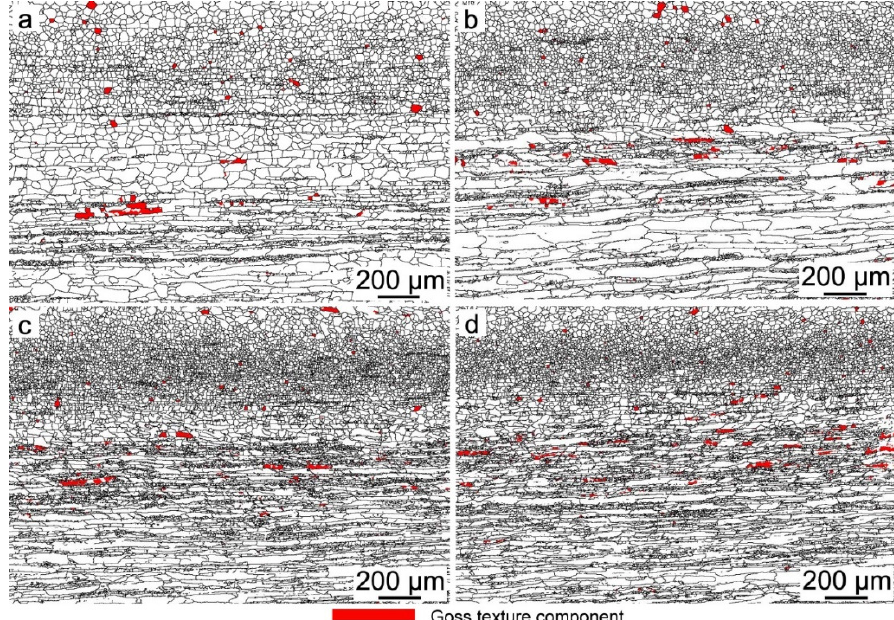
Figure 7. Goss texture of hot-rolled bands: ( a ) Nb-free, ( b ) Nb-0.005 wt%, ( c ) Nb-0.009 wt% and ( d ) Nb-0.025 wt%.